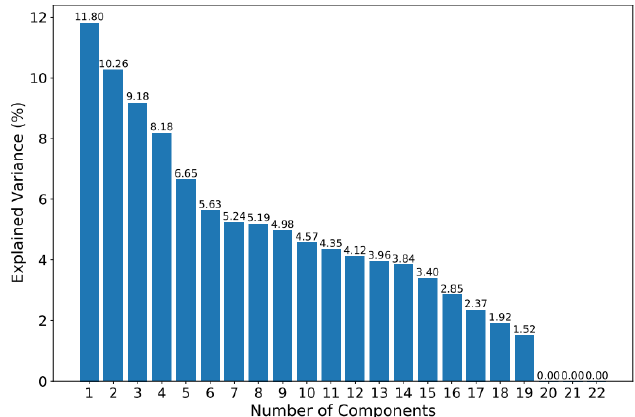
Figure 3. Visualization of the explained variance of each component.